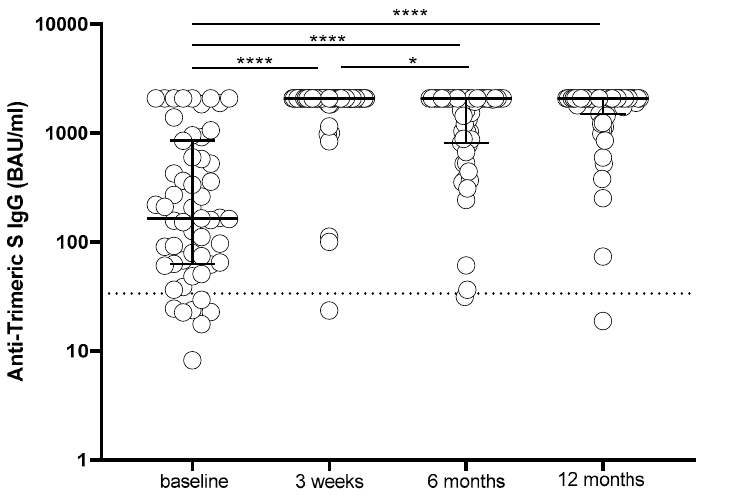
Figure 1. Anti-trimeric S IgG levels elicited in 55 patients by the third dose of the BNT162b2 vaccine measured at the time of administration of the third dose (baseline) and 3 weeks, 6 months and 12 months after the third dose. IgG, immunoglobulin G; S, spike; **** p < 0.0001; * p < 0.05. In order to evaluate the role of a fourth dose, anti-trimeric S IgG levels were measured in subjects who received a fourth dose (21/55; 38.2%) at a median of 192 days after the third dose (range 119–222 days) and in subjects who did not receive a fourth dose (34/55; 61.8%). Although 14/21 (66.7%) subjects who received a fourth dose showed the maximum